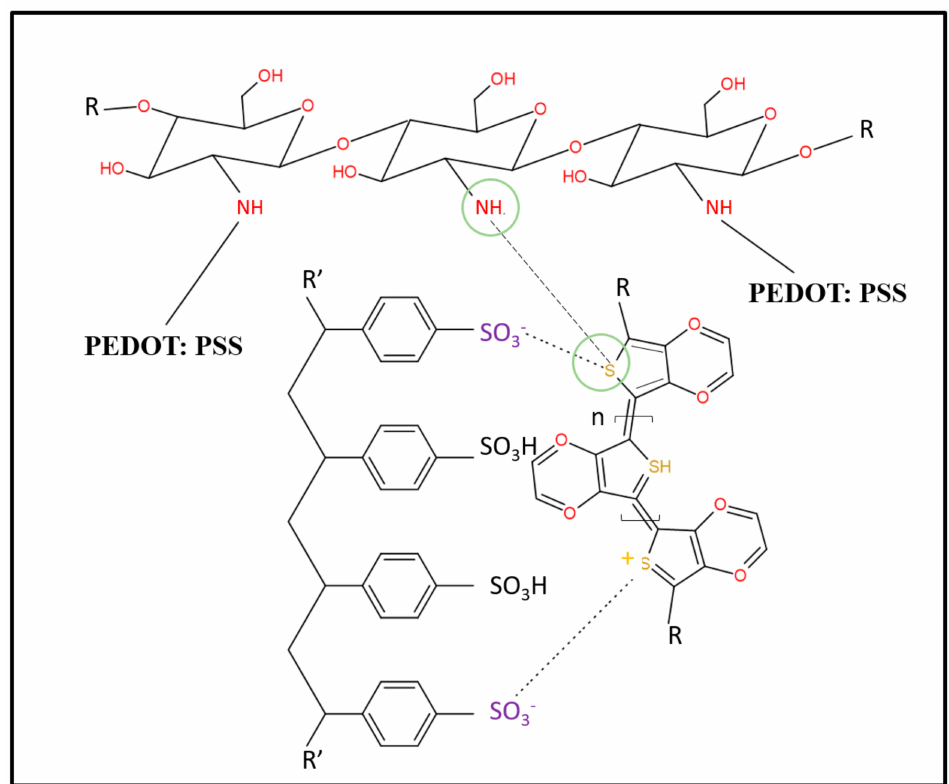
Figure 9. Chemical interaction between the amino group of chitosan and the thiophene ring of